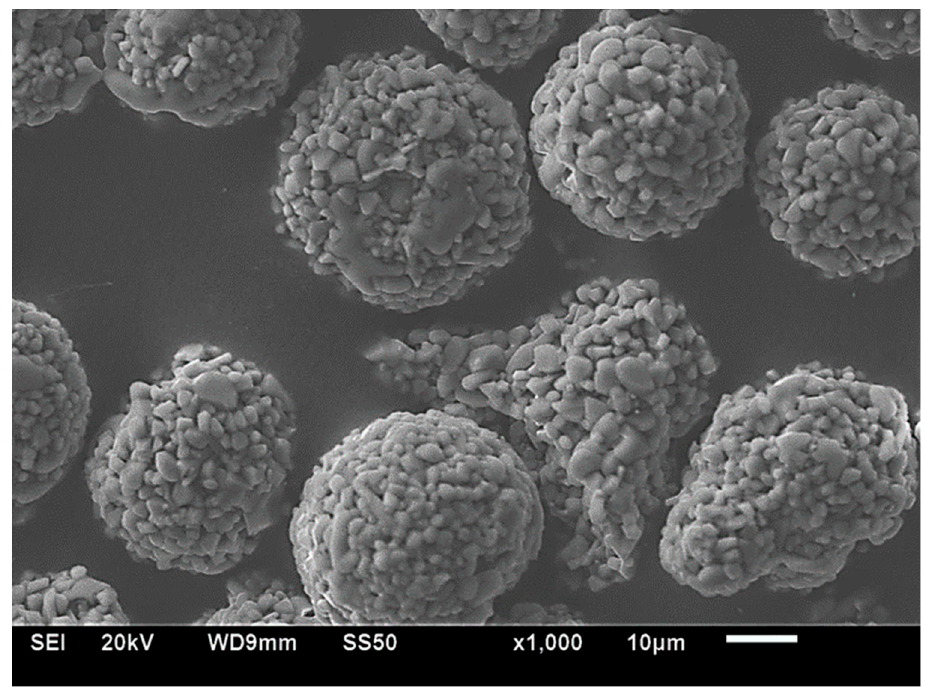
+ 13 wt% TiO 2 O 3 2 powder in the delivery